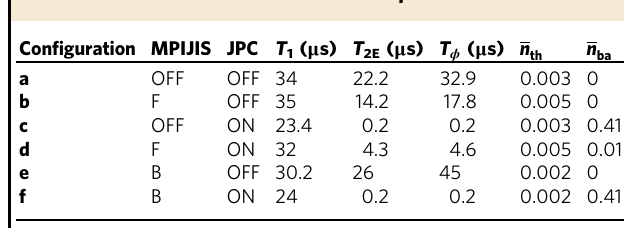
Table 1 Coherence and backaction